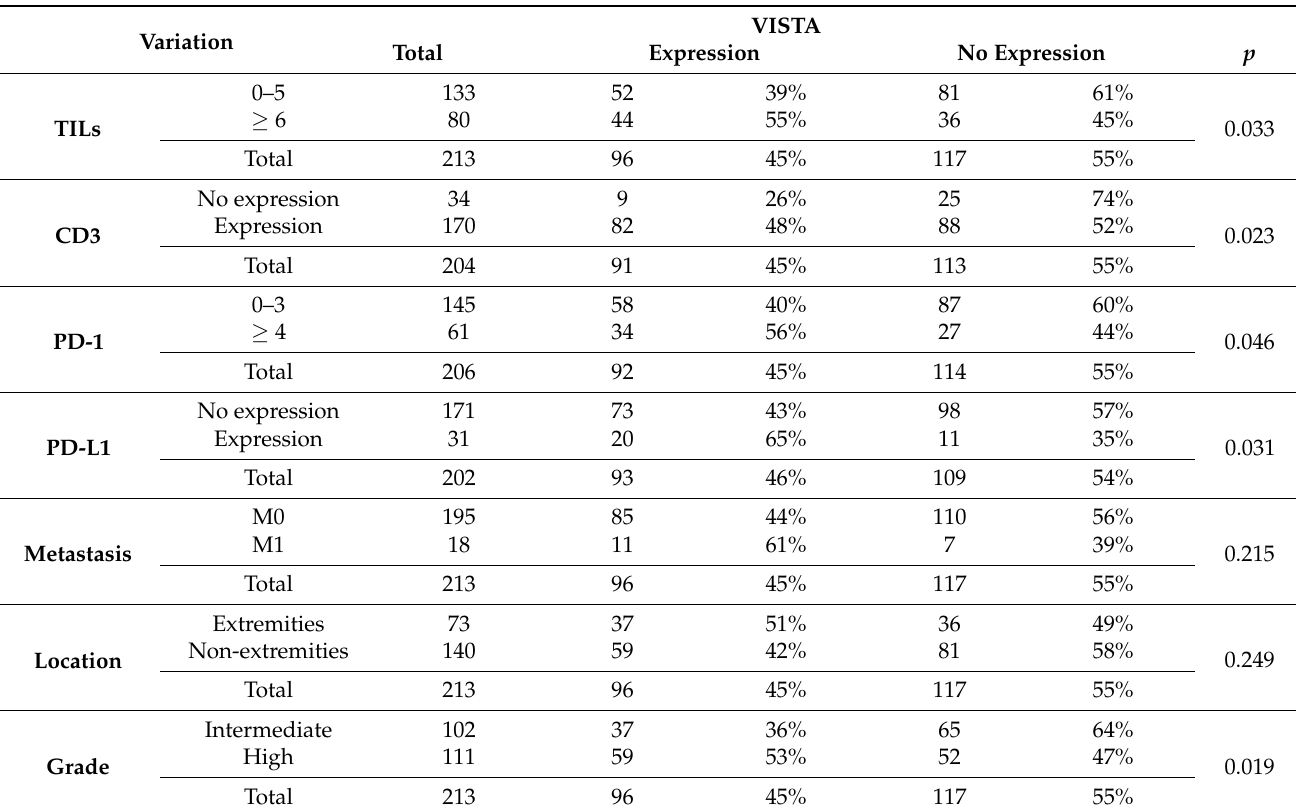
Table 3. Association between V domain immunoglobulin suppressor of T cell activation (VISTA) expression and clinicopathological parameter grading: TILs, tumour-infiltrating lymphocytes. The Chi-square test was used to test for the independence of